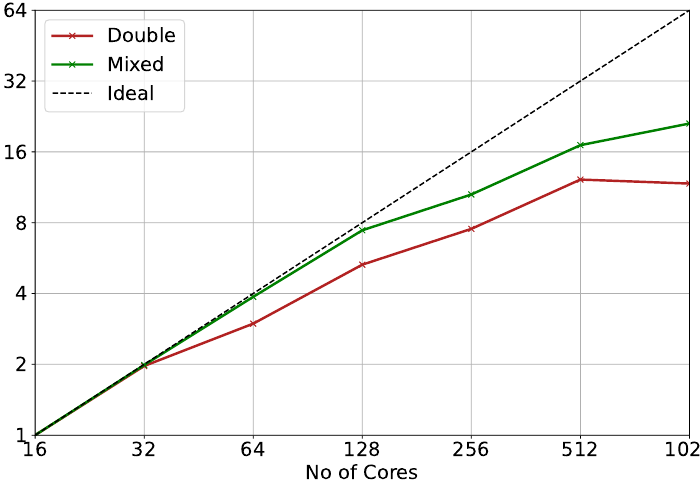
Figure 7. Overall speed-up for double precision (red) and projection of improvement with mixed precision (green) for MOM mechanism at T42 resolution ( ∼ 2 ◦ × 2 ◦